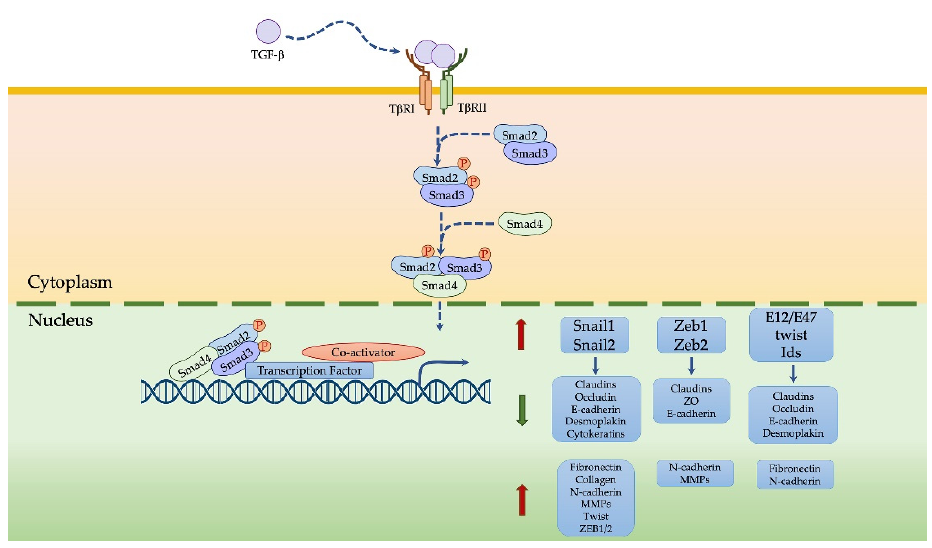
Figure 3. TGF β activation of EMT transcription factors.